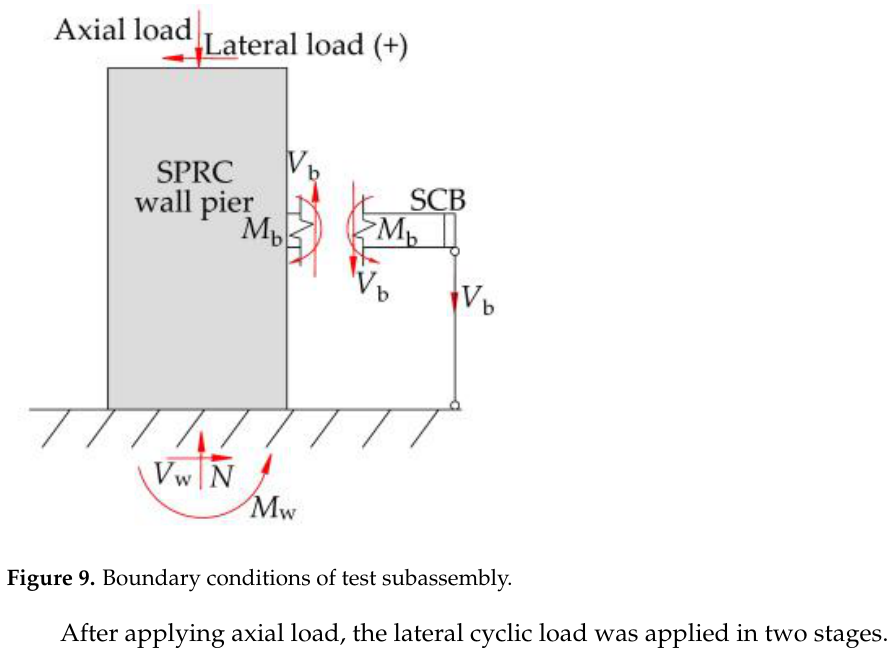
Figure 8. Test setup.